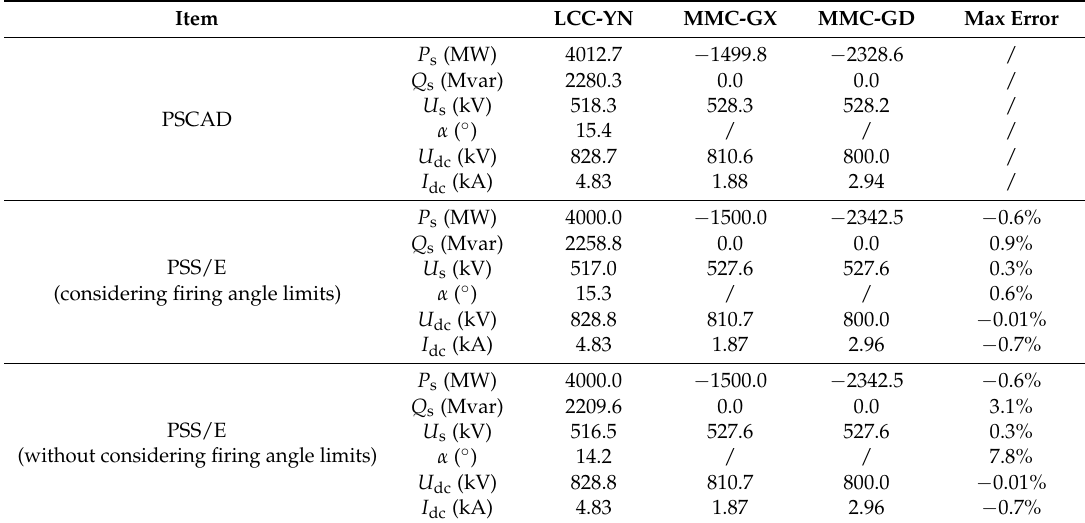
Table 3. Power Flow Results of Case